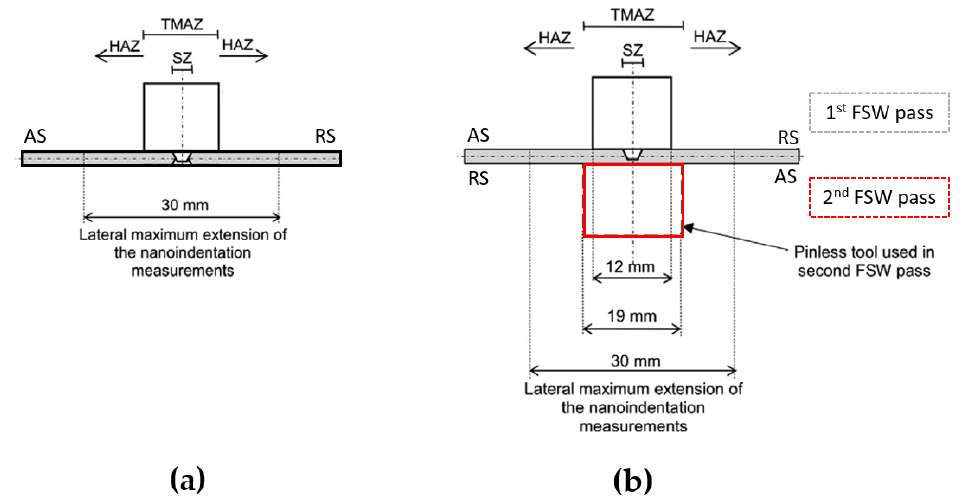
Figure 3. Comparison between ( a ) conventional FSW and ( b ) DS-FSW processes. PIN TOOL